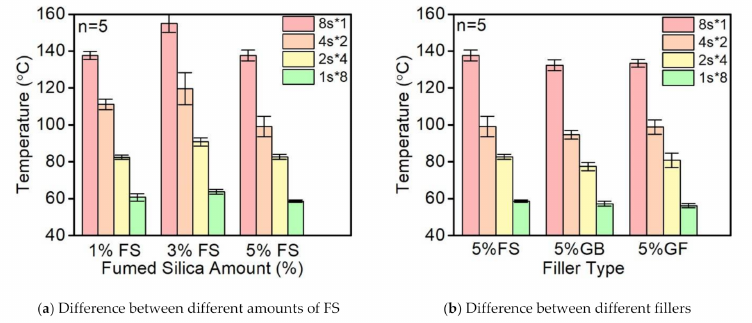
Figure 8. Comparison of the reaction temperatures using different curing